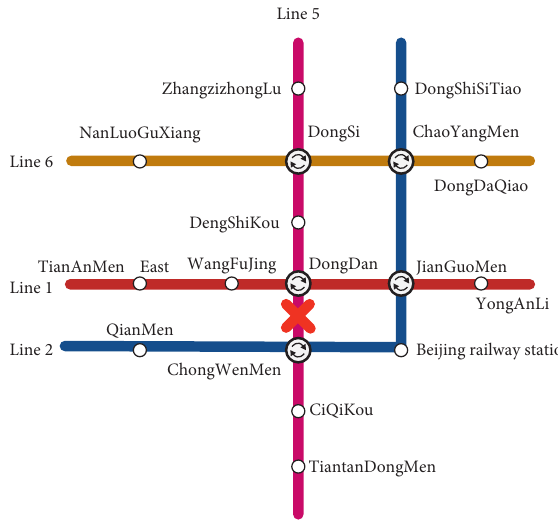
Figure 4: Travel route